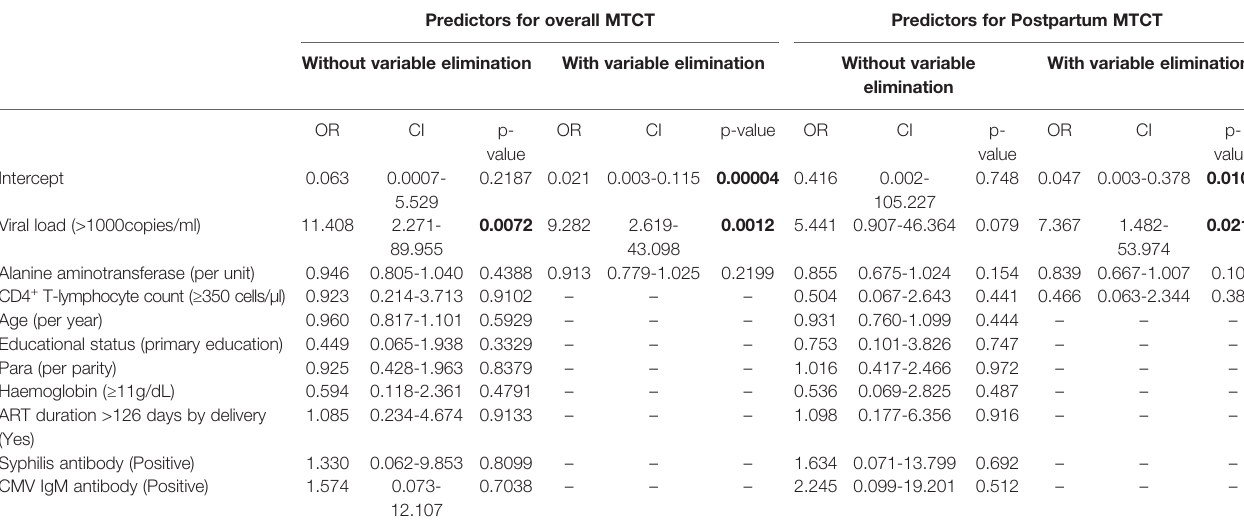
TABLE 3 | Predictors of overall and postpartum mother-to-child transmission of HIV in infected pregnant women at least 20 weeks of gestational age without variable elimination (423 observations) and with variable elimination (514